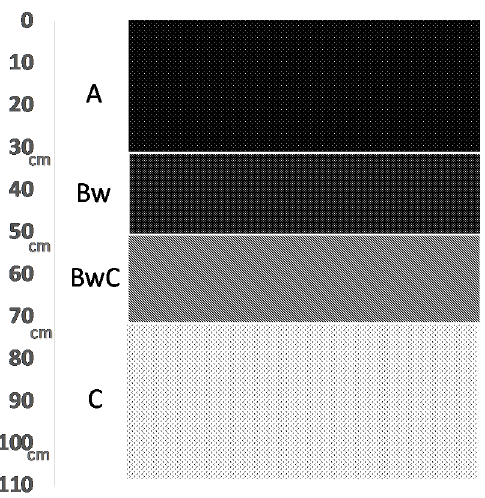
Figure 2. Soil profile at the experimental site.